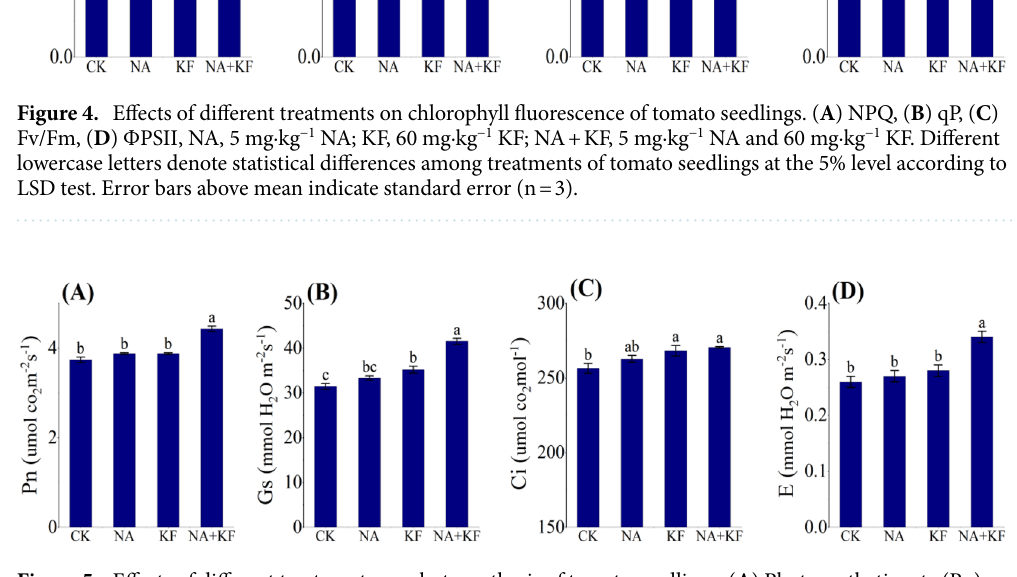
Figure 5. Effects of different treatments on photosynthesis of tomato seedlings. ( A ) Photosynthetic rate (Pn), ( B ) stomatal conductance (Gs), ( C ) intercellular CO 2 concentration (Ci), ( D ) transpiration rates of leaves ( E ), NA, 5 mg·kg −1 NA; KF, 60 mg·kg −1 KF; NA + KF, 5 mg·kg −1 NA and 60 mg·kg −1 KF. Different lowercase letters denote statistical differences among treatments of tomato seedlings at the 5% level according to LSD test. Error bars above mean indicate standard error (n = 3).